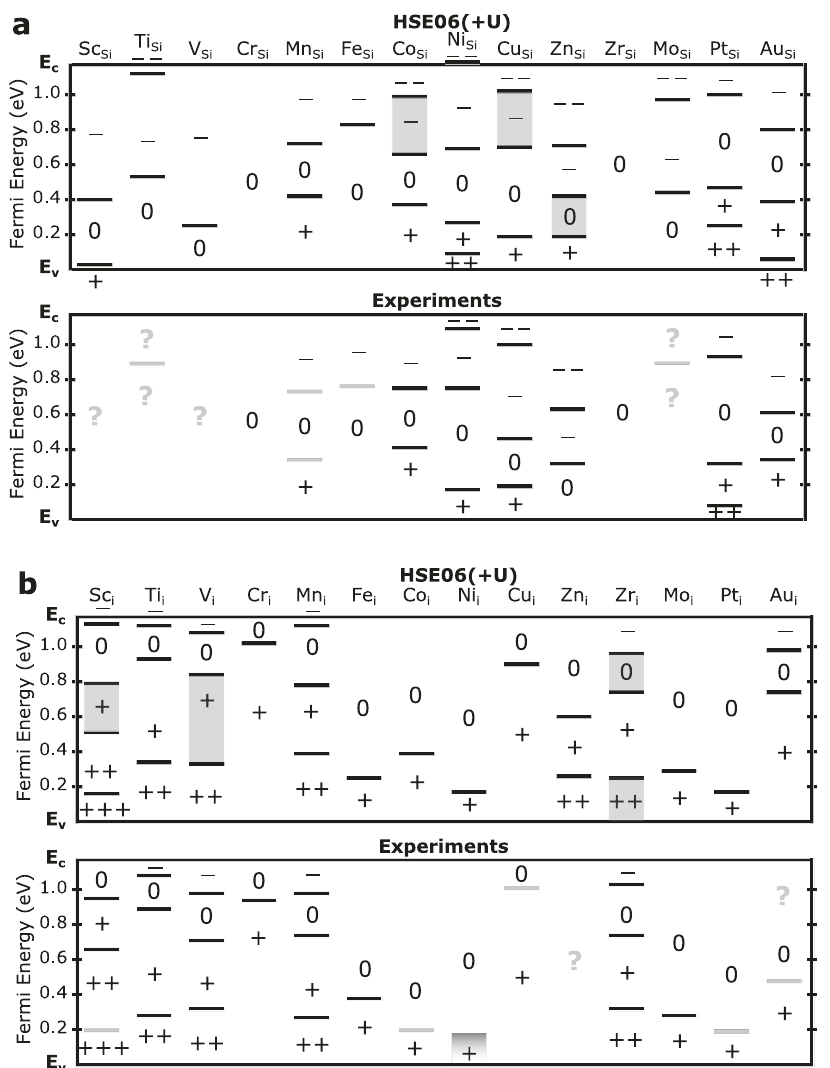
Fig. 8 Comparison between predicted and experimental charge transition levels (CTL). a and b are for substitutional and interstitial transition metal defects, respectively. Gray question marks and horizontal bars indicate the charge transition levels and charge states are still inconclusive in the literature. The gradient shade for interstitial Ni defect indicates that its CTL exists but the actual position is inconclusive. “ 0 ” with no horizontal bars indicates that no electrically active defects are observed within the Si band gap. 0, + , and − signs indicate the dominant charge state within the Fermi energy range. The gray shades highlight the candidates predicted in this